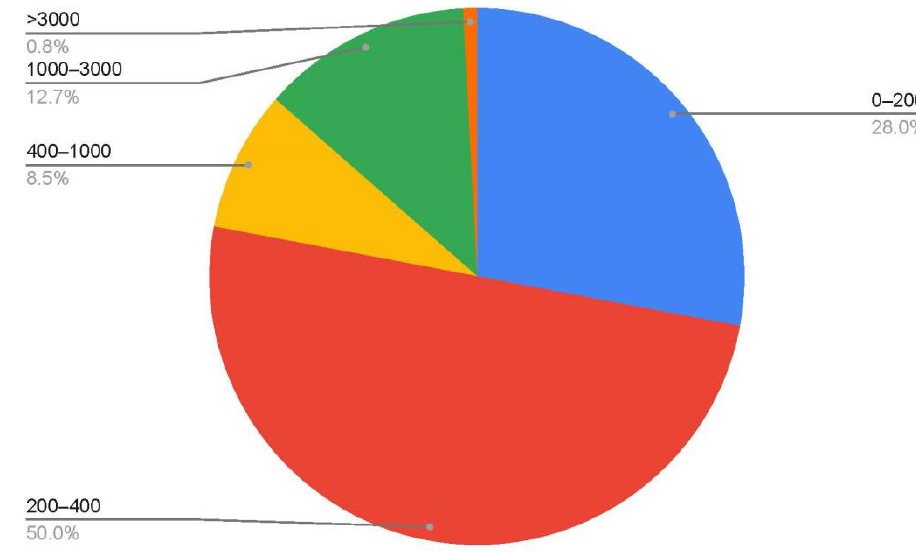
Figure 4. Distribution of siboglinid species by seas.